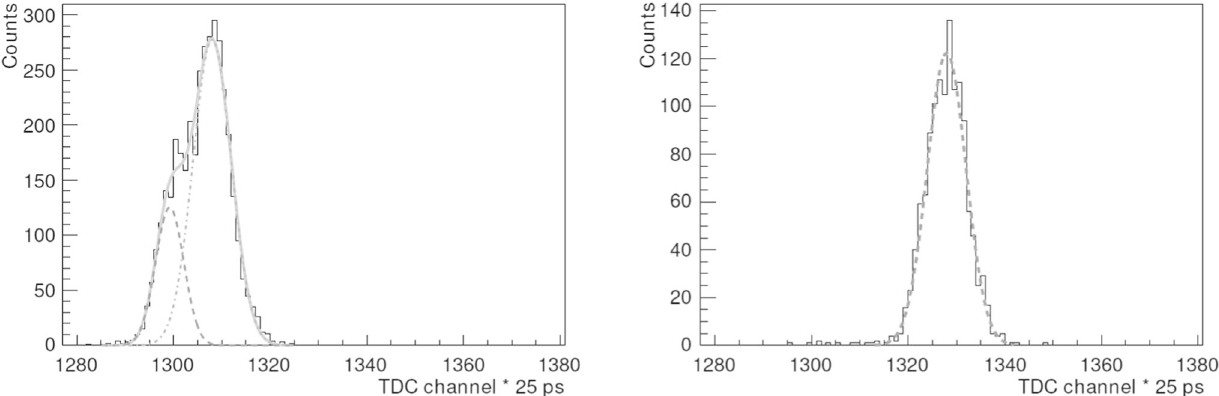
Fig. 4 Mass of fragments of Z/A with momentum of 13.9 A GeV / c . Left: Carbon ions show double Gaussian structure due to two isotopes of carbon in the beam. Right: beryllium ions show single Gaussian dis-